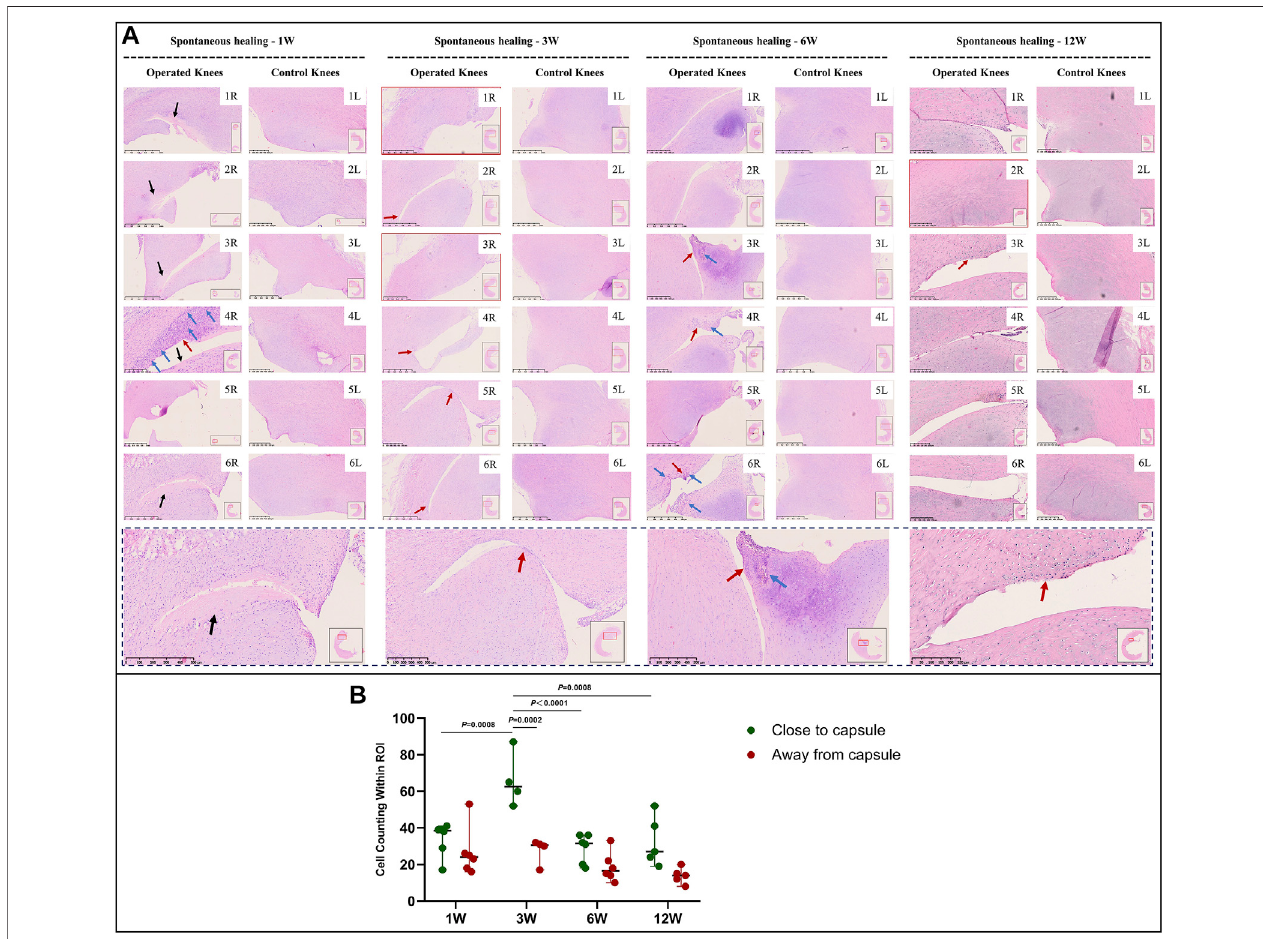
FIGURE2| HE stainingand recellularization evaluation in immature menisci. (A) HE staining. (B) Cell counting within theROIfor evaluation ofrecellularization close toanddistantfromthejointcapsuleinimmaturemenisci.Theserialnumberintheupperrightcornerofeachmacroscopicimageindicatesthenumberofeachspecimen. The black arrows indicate the area of cell death. The red arrows indicate cell clusters. The blue arrows indicate blood vessels. Images with a red border indicate histological specimens showing completely healed menisci. The lower panel of images with a black dotted-line border indicate representative specimens in the corresponding observation period. The cell counts within the ROI are expressed as median values with 95% CIs. The sample size for each group was six except for the 3 W ( n (cid:1) 4) and the 12 W group ( n (cid:1) 5); this discrepancy was owing to complete healing observed in two samples at 3 W and one sample at 12 W. W: weeks.